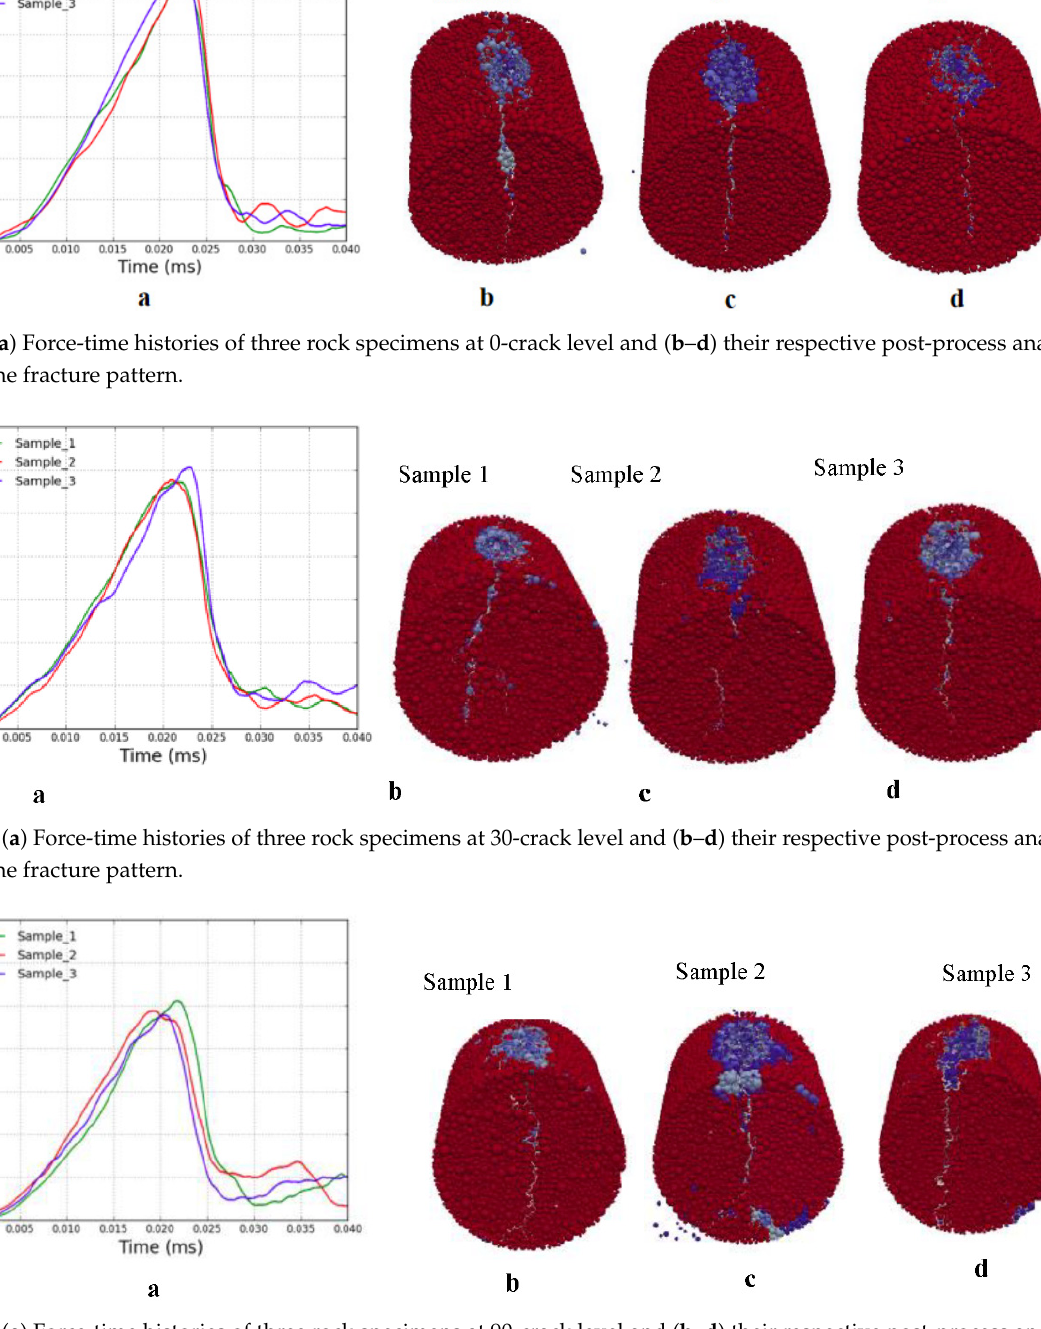
Figure 11. ( a ) Force-time histories of three rock specimens at 90-crack level and ( b – d ) their respective post-process analyses showing the fracture pattern.